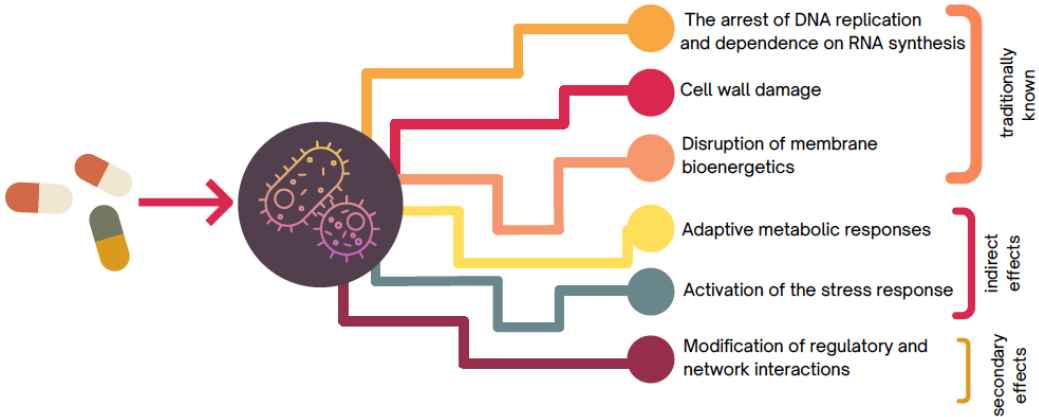
Figure 2. Illustration of the different events involved in cell death caused by antibiotics.